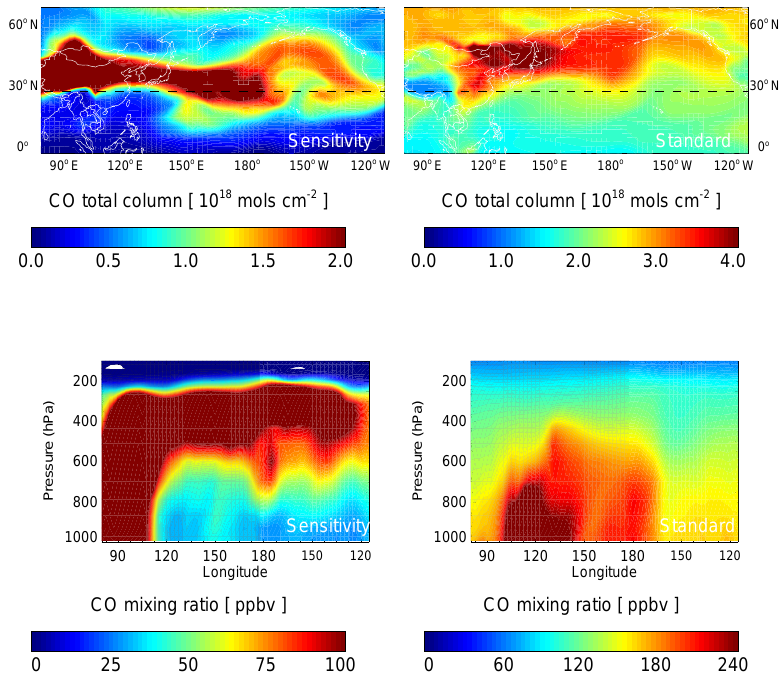
Fig. 6. Horizontal (first row) and vertical (second row) distributions of CO transport in the sensitivity (first column) and standard simulations (second column). The GFED biomass burning emissions are used in both simulations. See text for the details of the sensitivity simulation.